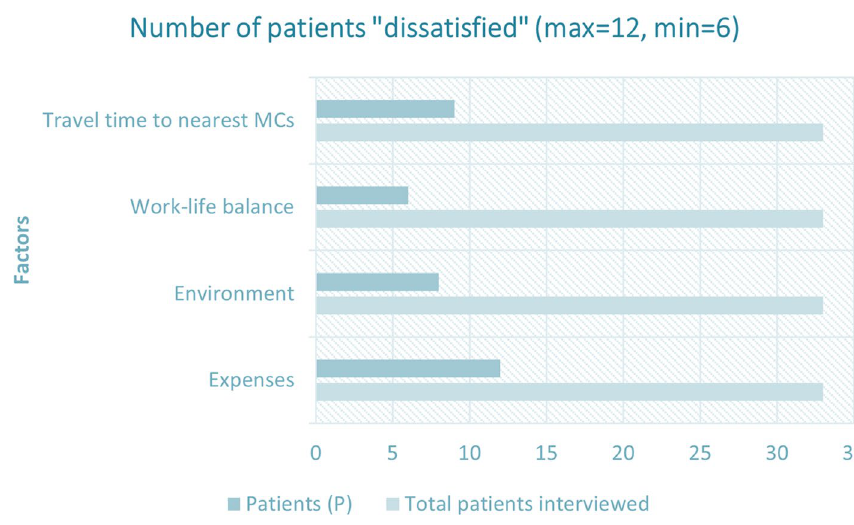
Fig. 7 Horizontal bar graph illustrating the number of patients dissatisfied with the scheme and services of mohalla clinics considering four different